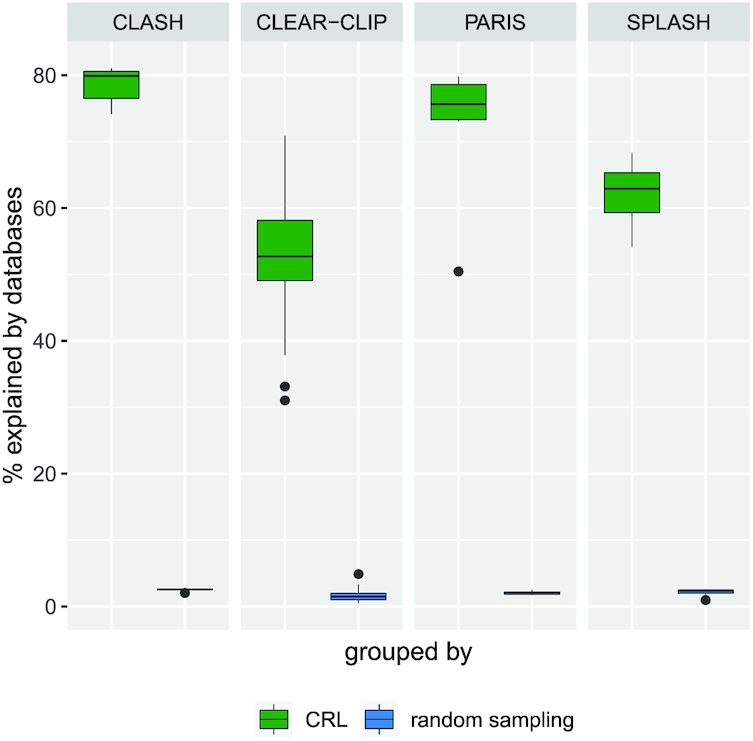
Validation of the CRLs from the different experimental protocols comparing the percentage of genes belonging to the CRLs that belong to the same protein family or have a similar KEGG identifier vs those when the genes were randomly sampled. In all datasets, it is clear that the genes constituting CRLs are found to be related in at least one of the annotation databases.